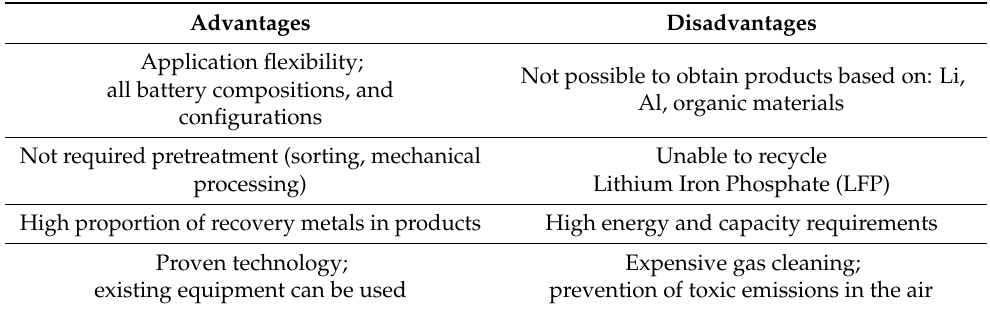
Table 6. Advantages and disadvantages of pyrometallurgical process according to [51]. Advantages Disadvantages Application flexibility; Not possible to obtain products based on: Li, all battery compositions, and Al, organic materials configurations Not required pretreatment (sorting, mechanical Unable to recycle processing) Lithium Iron Phosphate